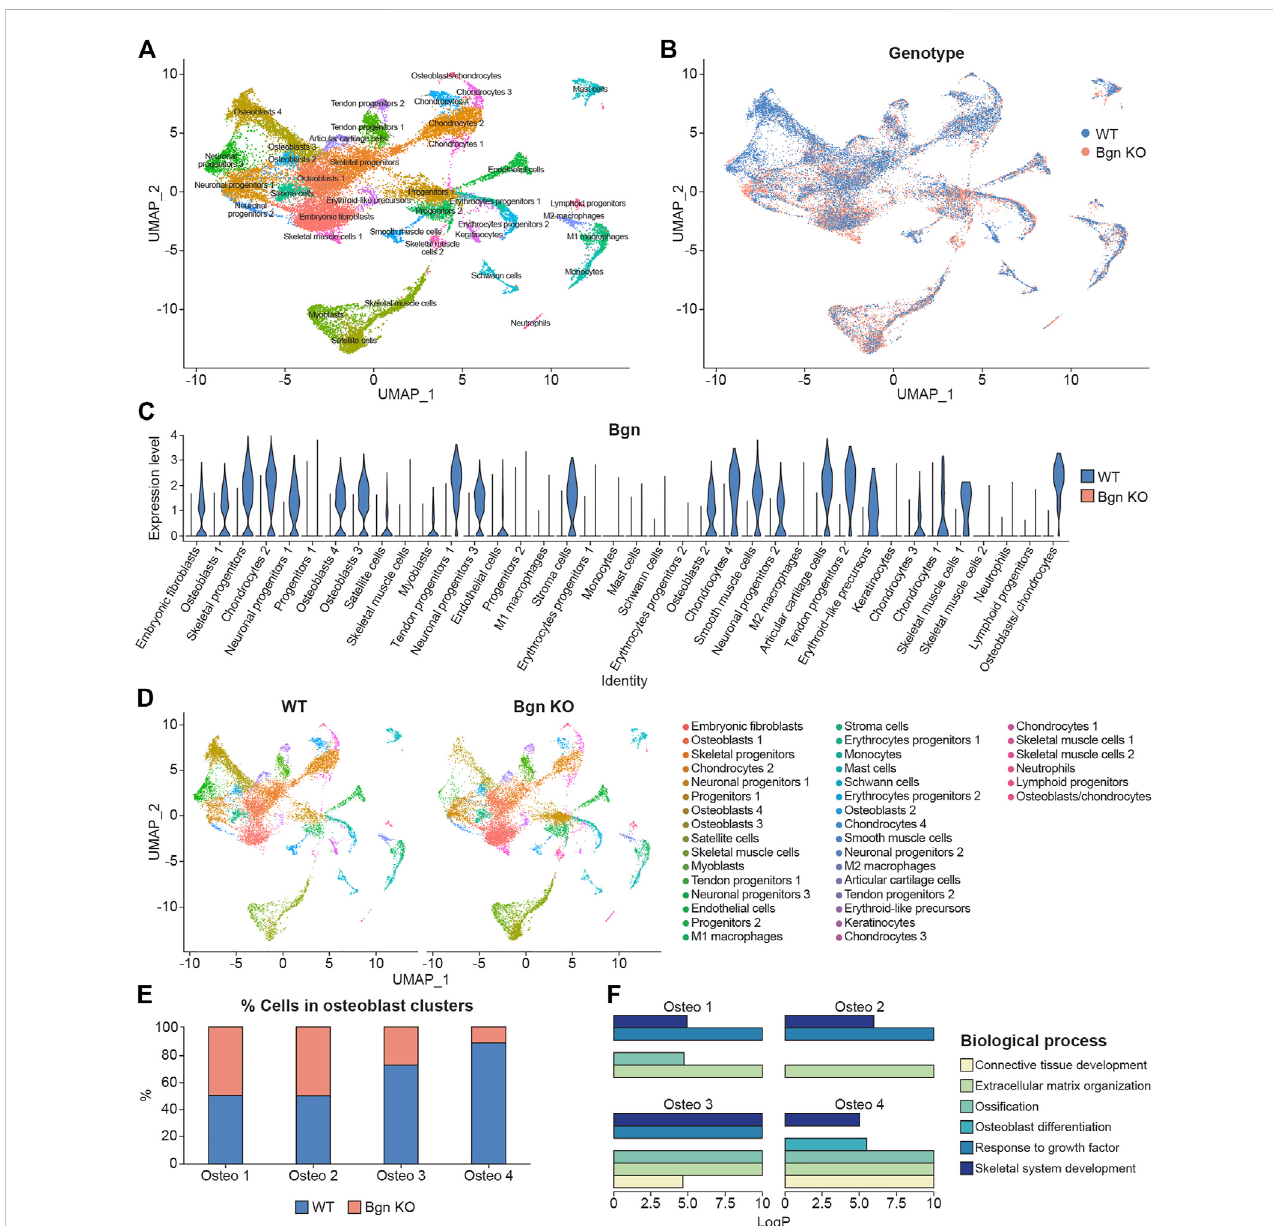
FIGURE 1 Single-cell sequencing of mouse embryonic bones shows Bgn is important for osteoblast differentiation. (A) UMAP visualization of transcriptional clusters derived from WT and Bgn KO cells (E16.5). Each point represents a single cell, colored according to cell type. The cells were clustered into 38 distinct types, which were de fi ned according to their unique transcriptomes. See also Supplementary Table S1. (B) UMAP visualization of the cells, colored according to their genotype origin. See also Supplementary Figure S1A. (C) Violin-plot comparison of Bgn gene expression in the different clusters, split according to their genotype origin. See also Supplementary Figure S1B. (D) UMAP visualization of the 38 clusters, WT compared with Bgn KO cells. See also Supplementary Figure S2. (E) The percentage of WT and Bgn KO cells that populate the osteoblast clusters. (F) GO analysis of the genes in the different osteoblast